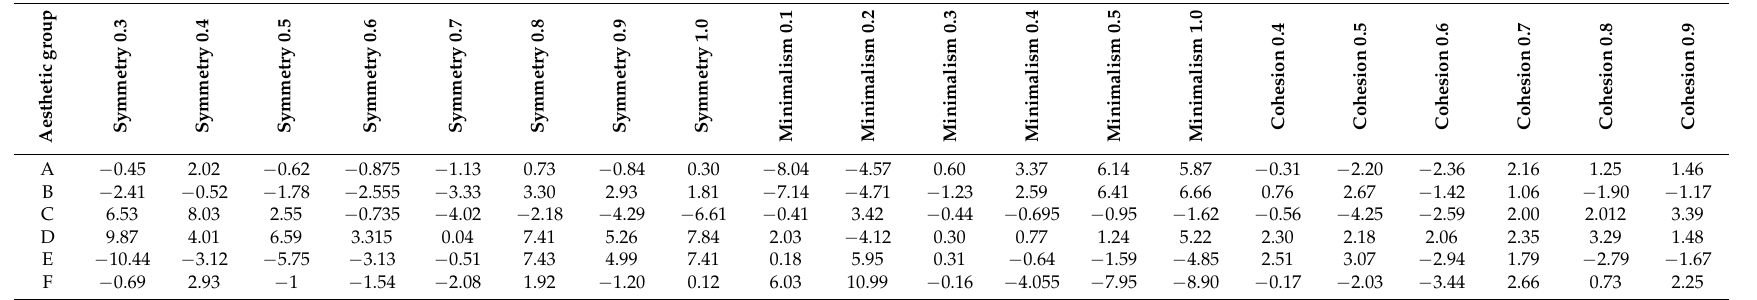
Table 3. Average part-worth utilities of each aesthetic value for each